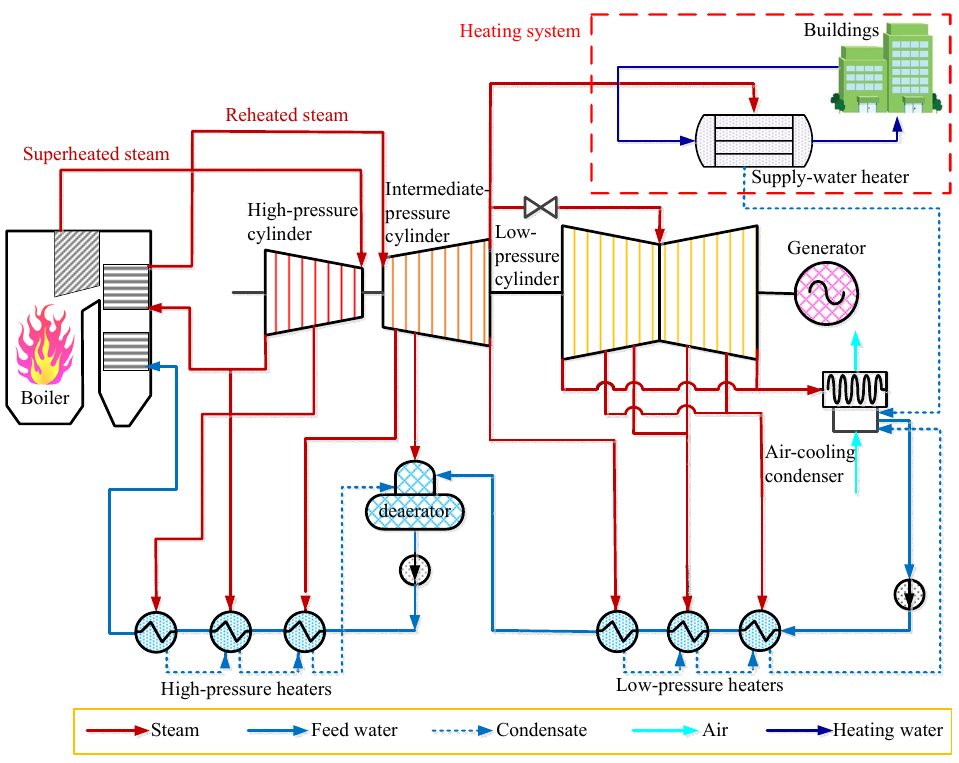
Figure 2. Diagram of the reference combined heat and power (CHP) unit with a regular heating system. Table 1. Main parameters of the reference combined heat and power (CHP) unit under the rated condition in the heating season.